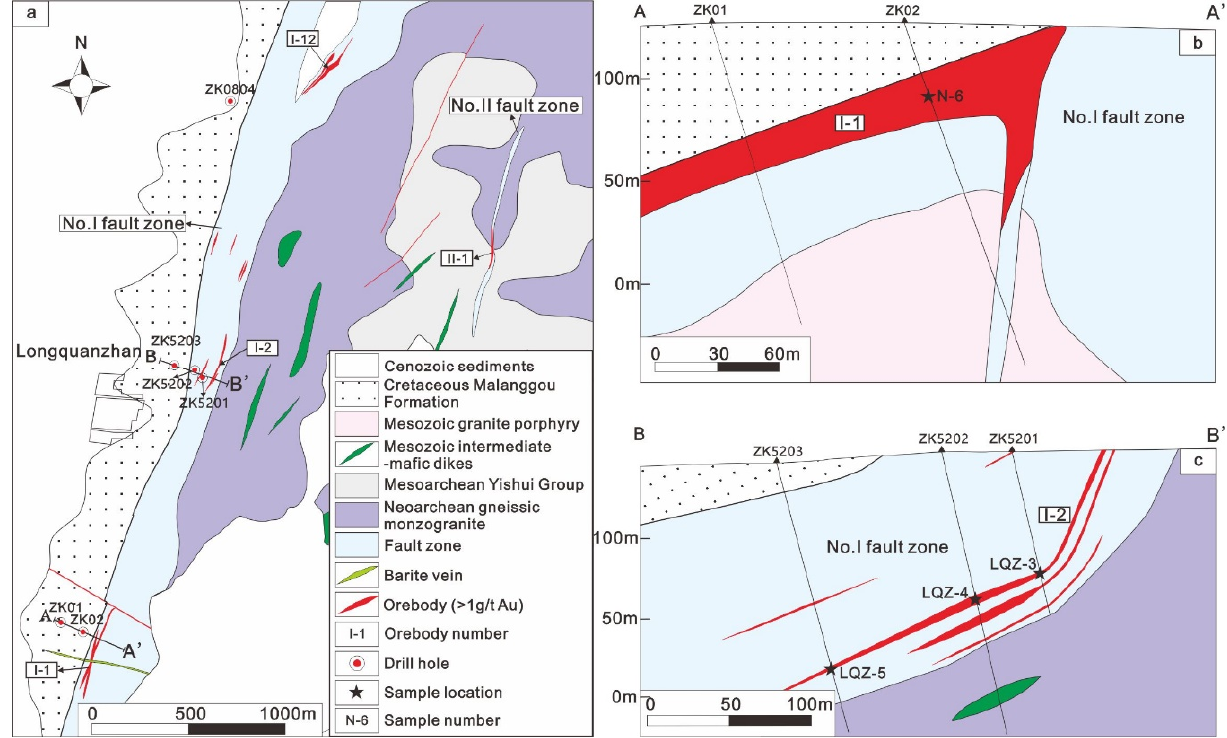
Figure 3. ( a ) Geological map of the Longquanzhan gold deposit; ( b ) geological profiles A-A’; and ( c ) geological profiles B-B’.